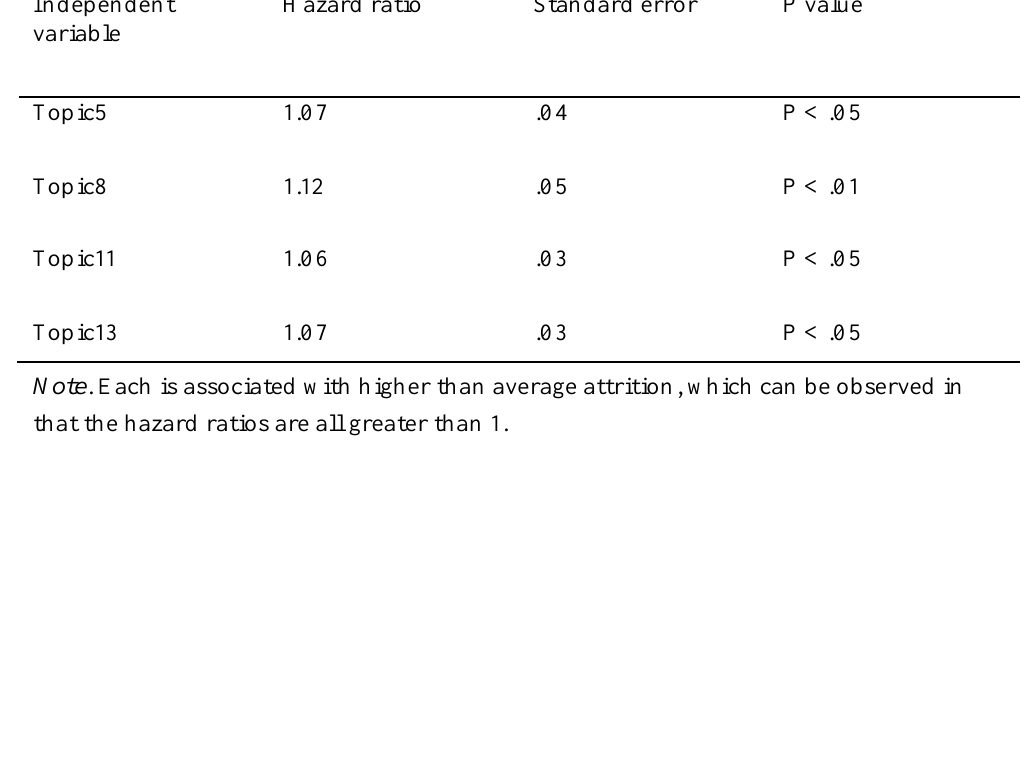
Hazard Ratios for Four Different Subcommunity Topics in the Fantasy Course Independent